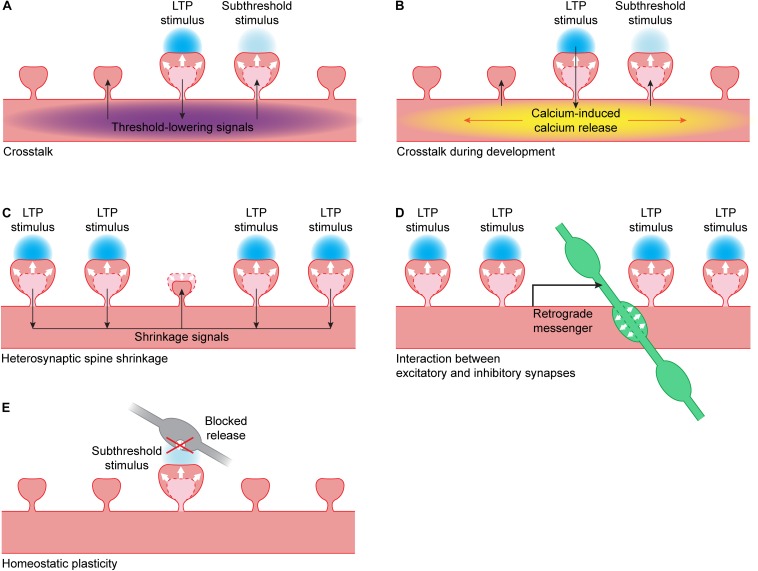
Interactions between synapses. (A) When LTP is induced in a single spine using glutamate uncaging (blue), this leads to the spread of threshold-lowering signals (purple) in the dendrite. When a nearby spine receives a stimulus that is normally subthreshold, spine growth will occur. Threshold-lowering signals include the small GTPases Ras, Rac1 and RhoA (Harvey et al., 2008; Murakoshi et al., 2011; Hedrick et al., 2016) and BDNF-TrkB signaling (Harward et al., 2016; Colgan et al., 2018). PKA and ERK activity also spreads over the dendrite but it is unclear if these kinases are able to lower the LTP threshold (Zhai et al., 2013). (B) During development, the calcium influx in a single spine during glutamate uncaging can trigger calcium-induced calcium release (yellow). This leads to propagating calcium waves in the dendrite, and a nearby spine receiving a stimulus that is normally subthreshold will now show spine growth (Lee et al., 2016). (C) When a cluster of spines undergo LTP, this can lead to the activation of shrinkage signals. These signals can induce shrinkage of an unstimulated dendritic spine nearby (Oh et al., 2015). (D) When a cluster of spines undergo LTP, this can lead to the production of a retrograde messenger by the postsynaptic neuron. This messenger can trigger the growth of a presynaptic inhibitory bouton (green) nearby (Hu et al., 2019). (E) When vesicle fusion in the presynapse (gray) has been blocked for a prolonged period of time, this can lead to a lowering of the LTP threshold: when a spine receives a stimulus that is normally subthreshold, it will show spine growth (Lee et al., 2010).